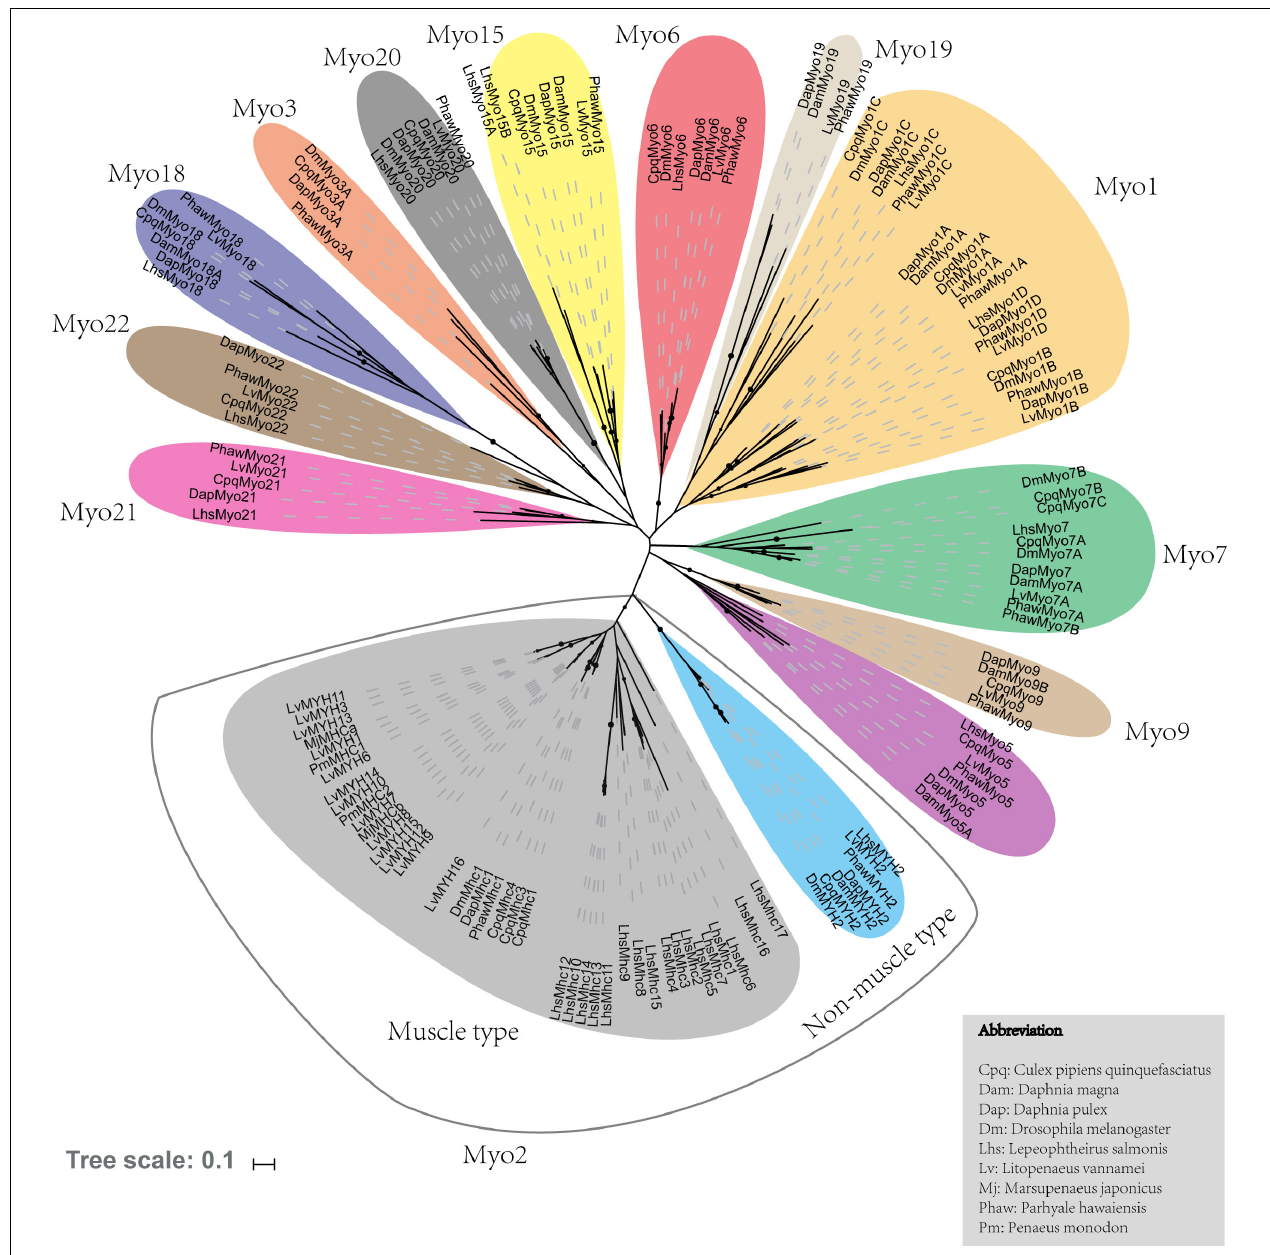
FIGURE 1 | Phylogenetic tree of myosin head domains generated using the neighbor-joining method (MEGA7 software) with bootstrapping replication set at 1000. The myosin groups are identified in roman numerals beside each clade. Myosin genes from the following organisms were used: Cpq, Culex pipiens quinquefasciatus ; Dam , Daphnia magna ; Dm, Drosophila melanogaster ; Dap, Daphnia duplex ; Lhs, Lepeophtheirus salmonis ; Lv, Litopenaeus. vannamei ; Mj, Marsupenaeus japonicus ; Phaw, Parhyale hawaiensis ; Pm, Penaeus monodon